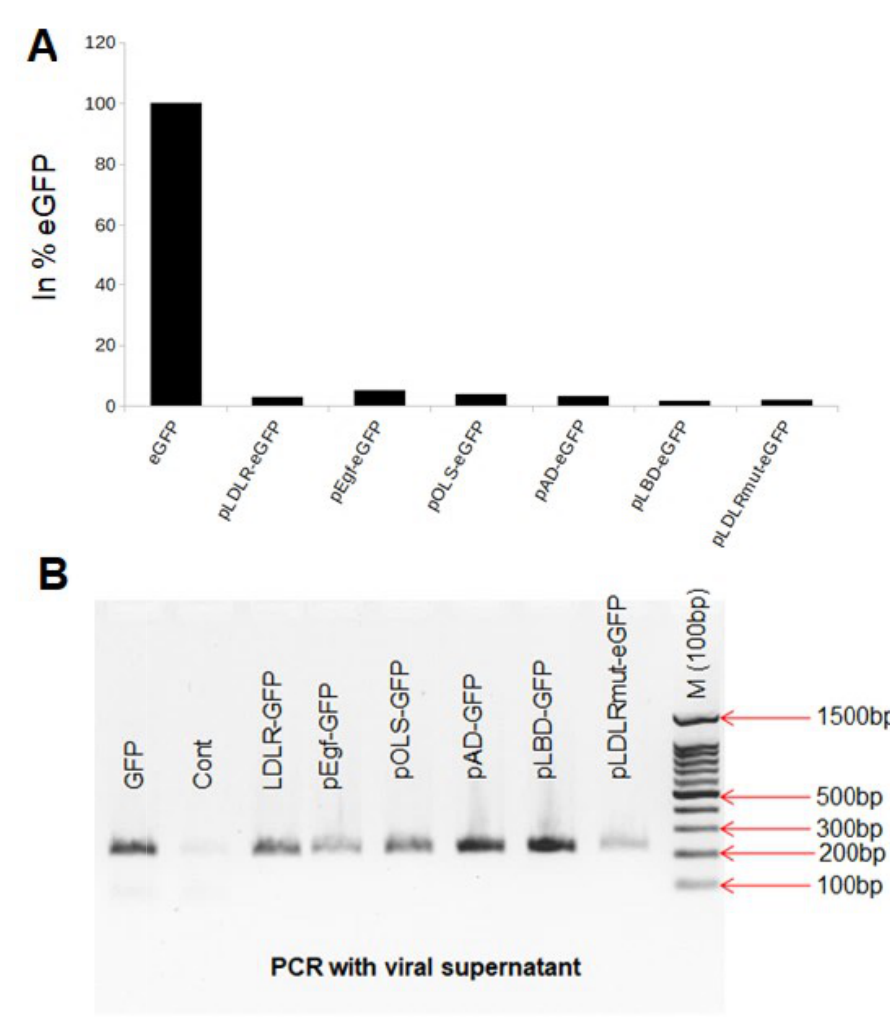
Figure 2. Transduction of 293T cells with LDLReGFP supernatant including di ff erent